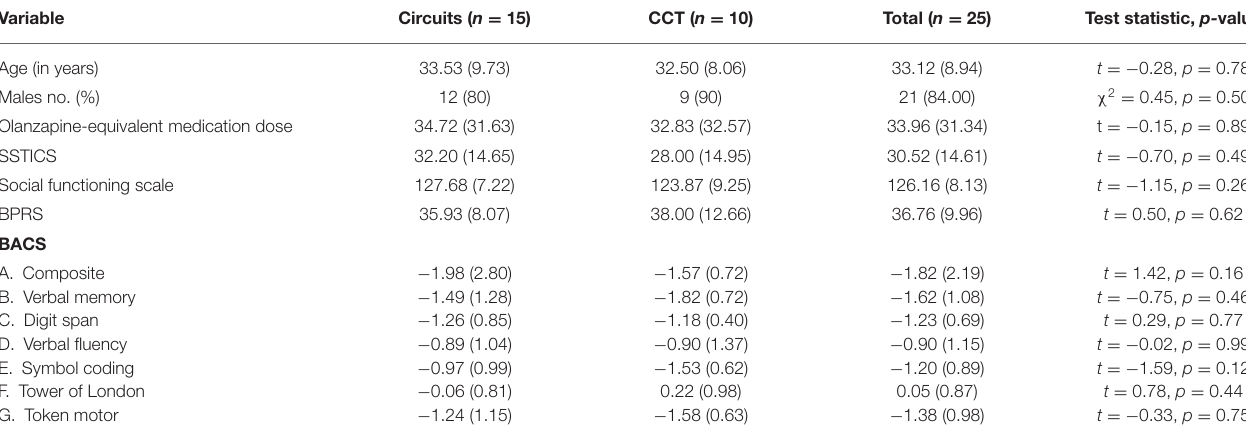
TABLE 1 | Means and standard deviations (SD) for baseline demographic and cognitive variables.